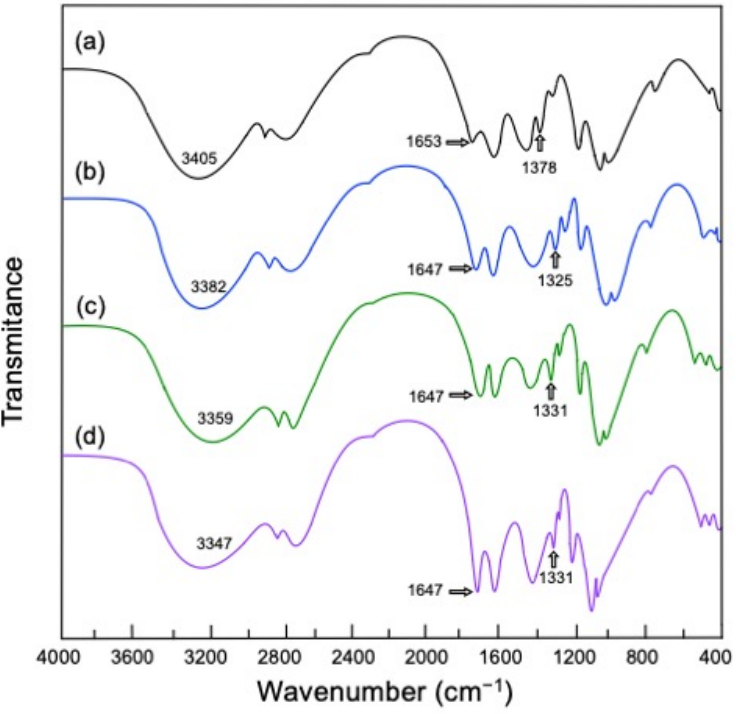
Figure 4. FT-IR spectra of chitosan (CH) and squid gelatin hydrolysates (SGH) films: ( a )—100 CH/0 SGH, ( b )—90 CH/10 SGH, ( c )—80 CH/20 SGH, and ( d )—60 CH/40 SGH.